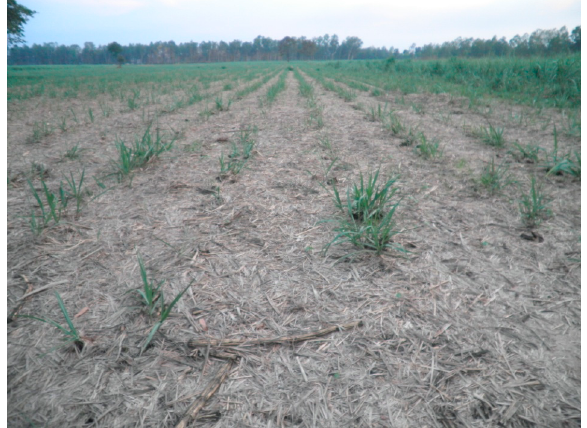
Figure 7. Sugarcane field after harvesting using the sugarcane harvester.